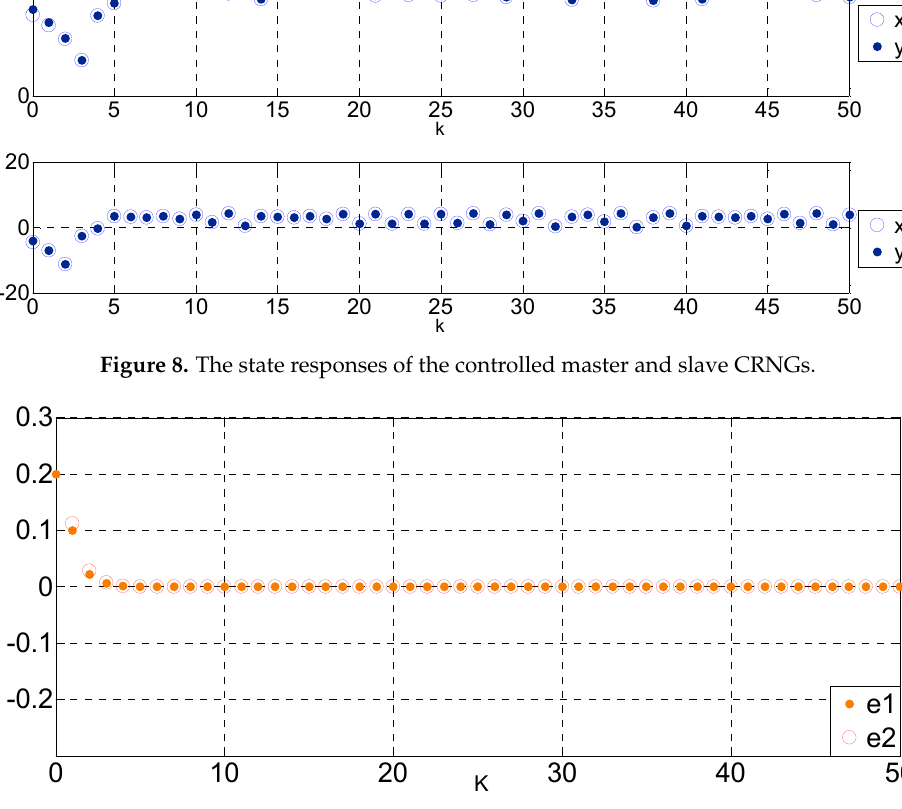
Figure 9. The error responses of the controlled master and slave CRNGs.